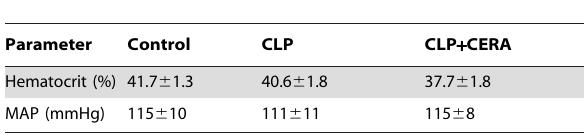
Table 2. Hemodynamic parameters.